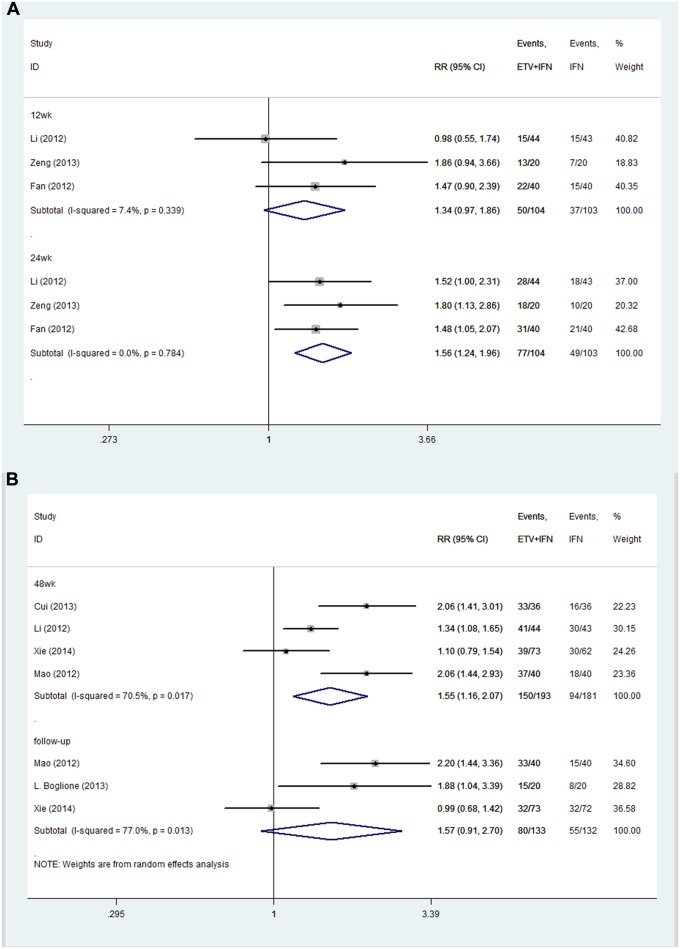
Forest Plot for ALT Normalization when IFN was used as the Control Group.(A) Forest plot for ALT normalization based on a random-effects model. (B) Forest plot for ALT normalization based on a fixed-effects model.